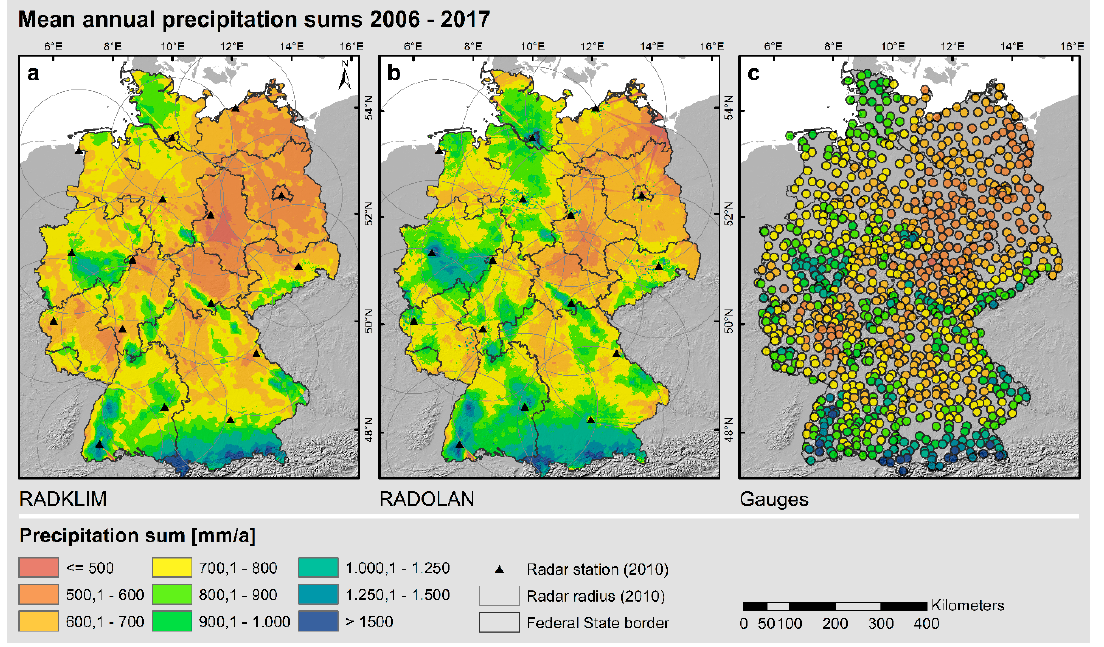
Figure 3. Mean annual precipitation sums for the period 2006 to 2017 derived from ( a ) RADKLIM, ( b ) RADOLAN and ( c ) gauge data.